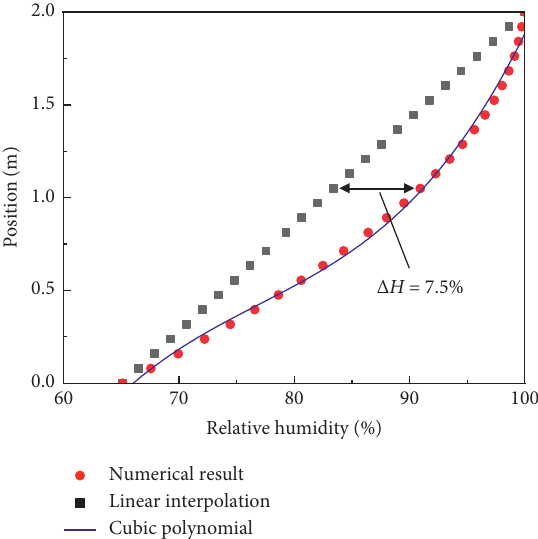
Figure 12: Distribution of RH along the path